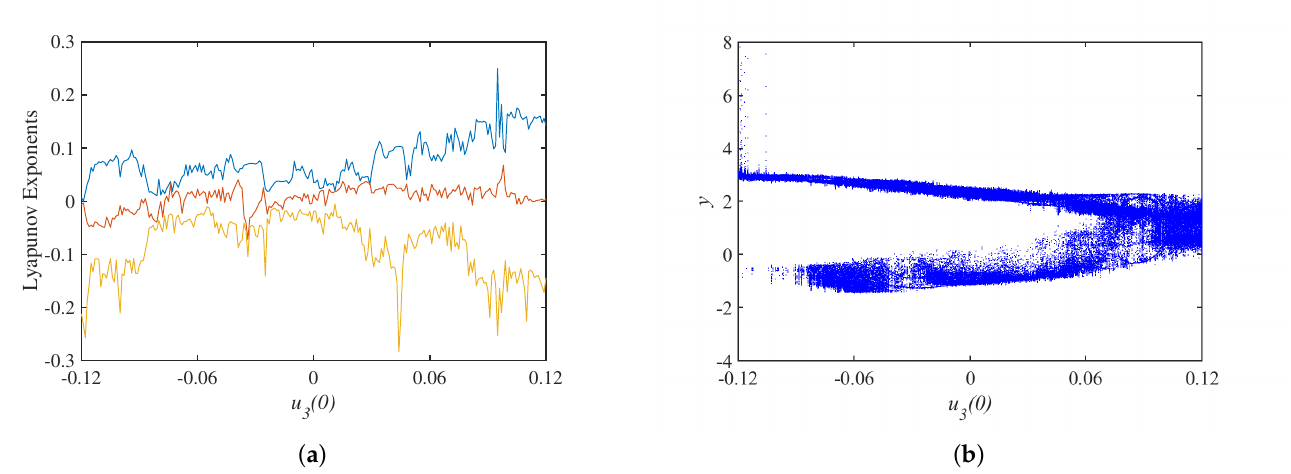
Figure 8. Dynamics with under initial state u 3 ( 0 ) : ( a ) Lyapunov exponents spectrum; ( b ) bifurca- tion